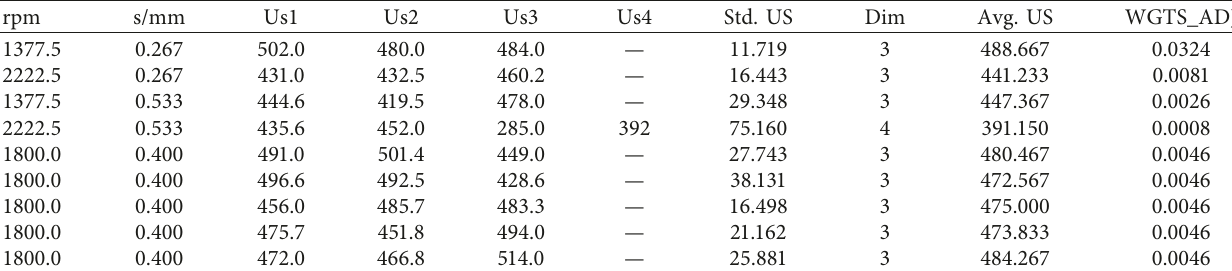
Table 5: Ultimate strength experimental responses.